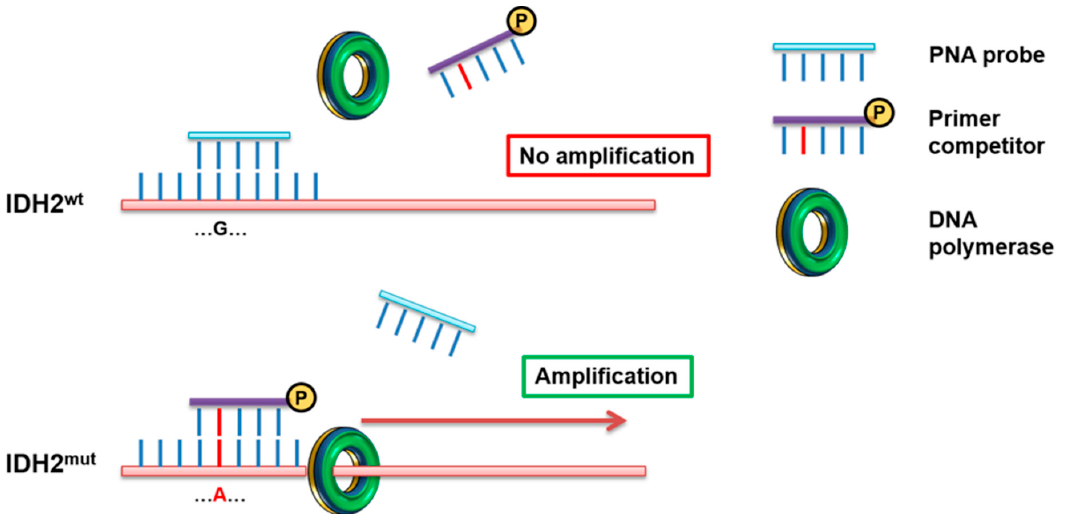
Figure 1. PNA-PCR clamping experimental design. Amplification of IDH2 was performed in